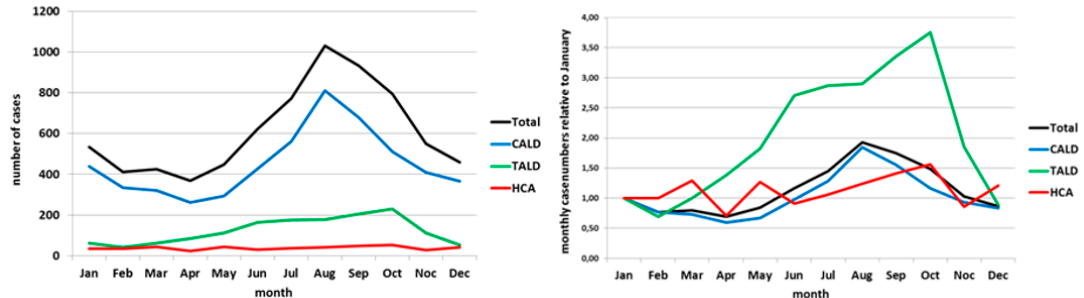
Figure 1. Left panel: absolute case numbers by month and exposure category; Germany, pooled data 2005–2015. Right panel: monthly case numbers (relative to January) by month and exposure category; Germany, pooled data 2005–2015.